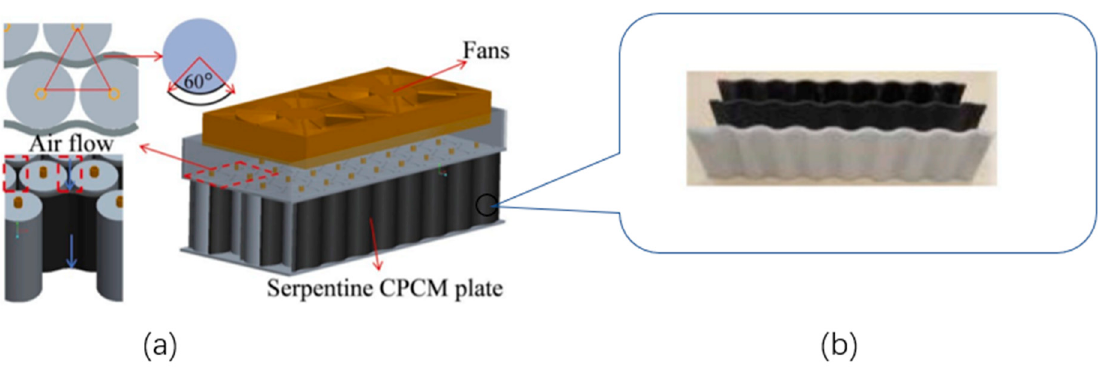
Figure 12. Schematic diagram of the structure of the serpentine phase-change material battery pack, ( a ) the arrangement of the serpentine phase change material in the battery pack, ( b ) the serpentine phase-change material [81]. Reproduced from reference 81 with permission from Elsevier B.V., copyright 2020.